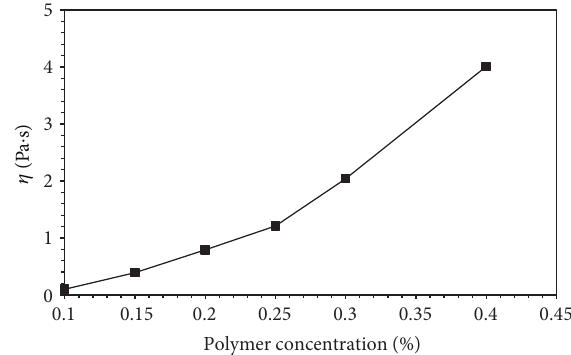
Figure 12: Effect of copolymer concentration on viscosity of SP solution at 50 ∘ C and shear rate of 0.01 s −1 .